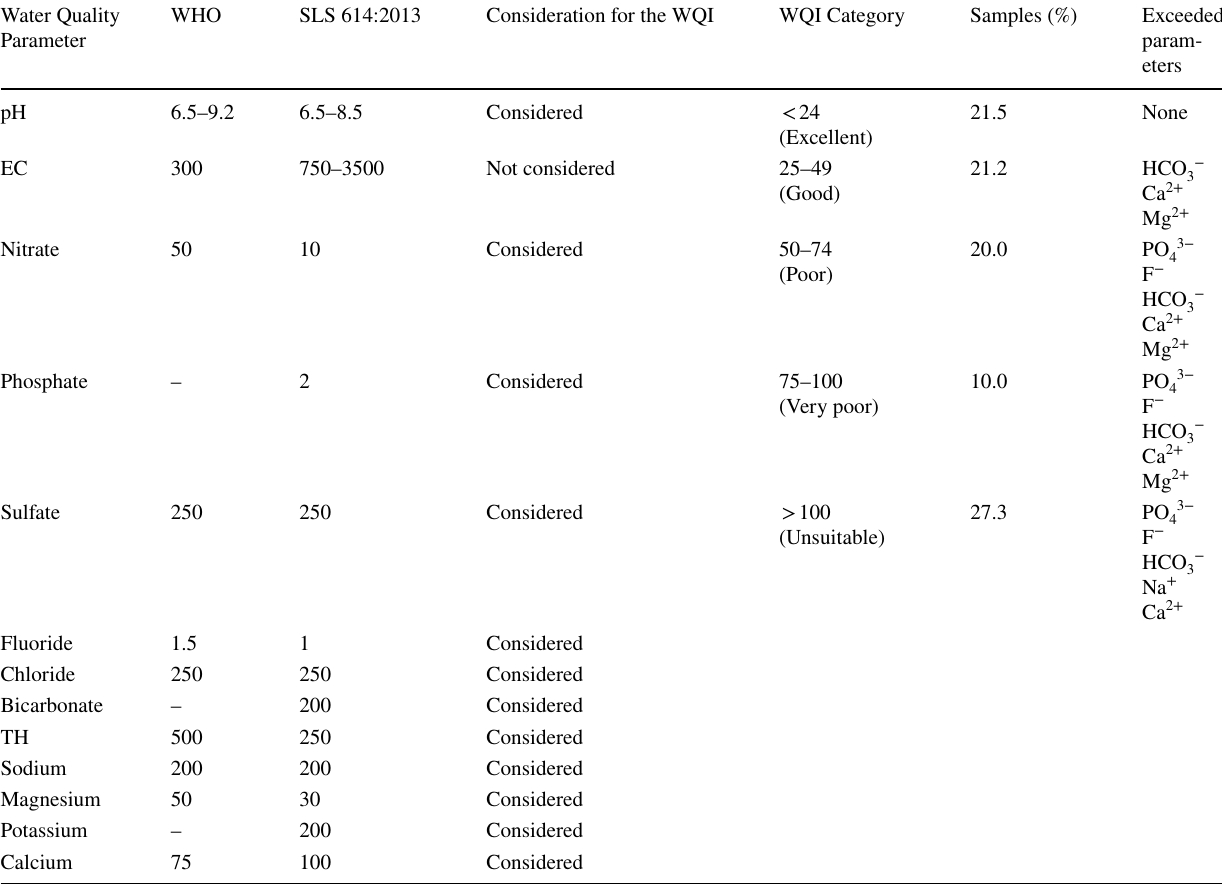
Table 5 Comparison of WQI with WHO and SLS 614:2013 water quality guidelines Water Quality